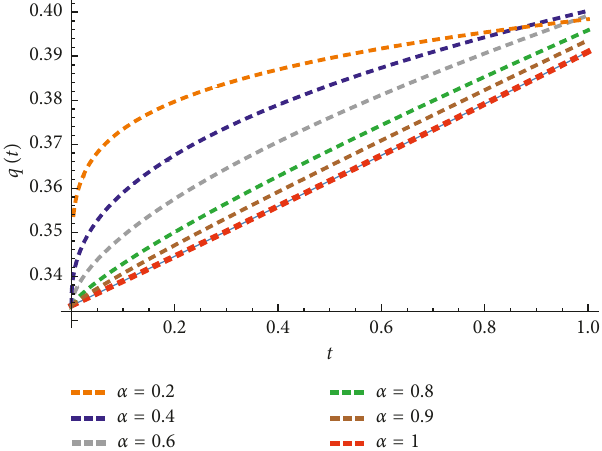
Figure 4: RPS solution plots of Example 2 for different values of α .